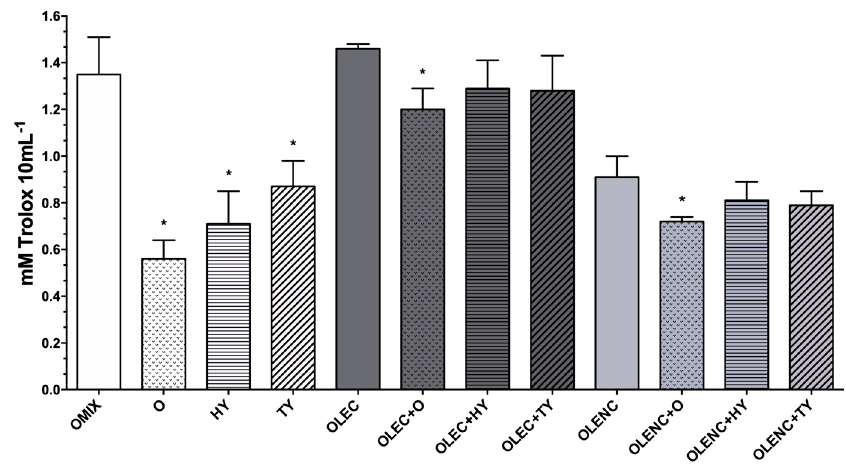
Figure 1. Antioxidant activity of olive leaves extract (OLE). Fresh (OLEC) and purified (OLENC) extracts, where indicated, were doped with pure oleuropein (O), hydroxytyrosol (HY), or tyrosol (TY). The concentrations are outlined in Table 2 of the Experimental Design. Results are shown as means ± SD of mM Trolox 10 mL -1 . * p < 0.05 between doped extracts and their corresponding non-doped extract or between the individual compounds and OMIX (Tukey’s multiple test). OMIX: Mixture of OLE’s major phenolic compounds.